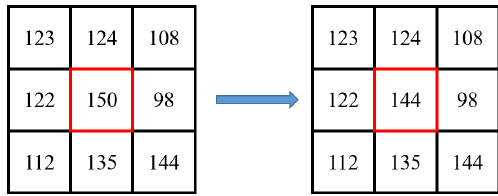
Figure 3. The maximum filtering method.